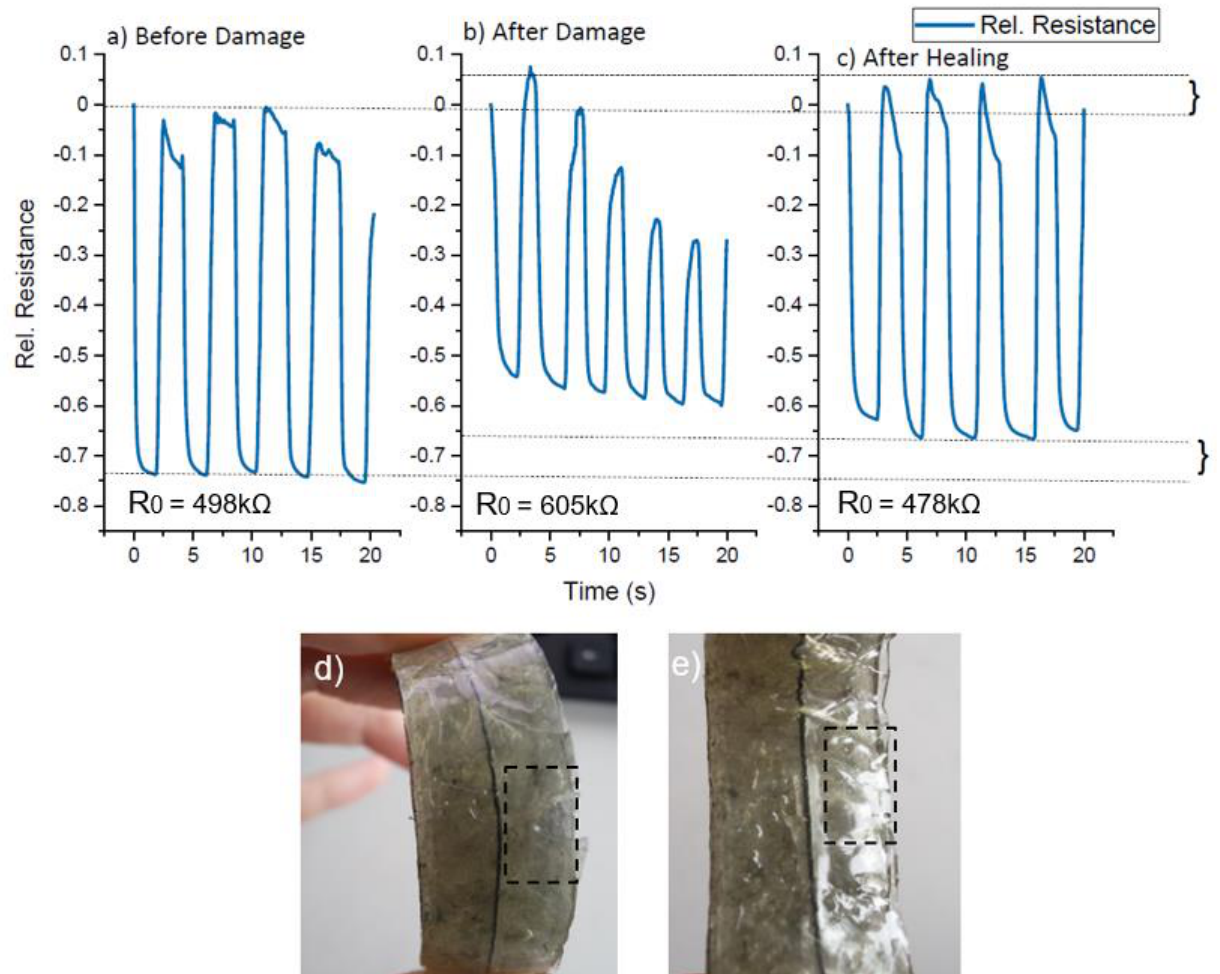
Figure 10. The electrical signal from the piezoresistive sensor in the skin during the bending motion (change between 0 and 90° bending angle) of the tendon-based soft robotic actuator in five repeated cycles ( a ) before and ( b ) after partial damage of the ShSFC matrix and ( c ) after the healing of the ShSFC matrix. The pneumatic-based bending actuator with ( d ) partially damaged and ( e ) healed ShSFC matrix.